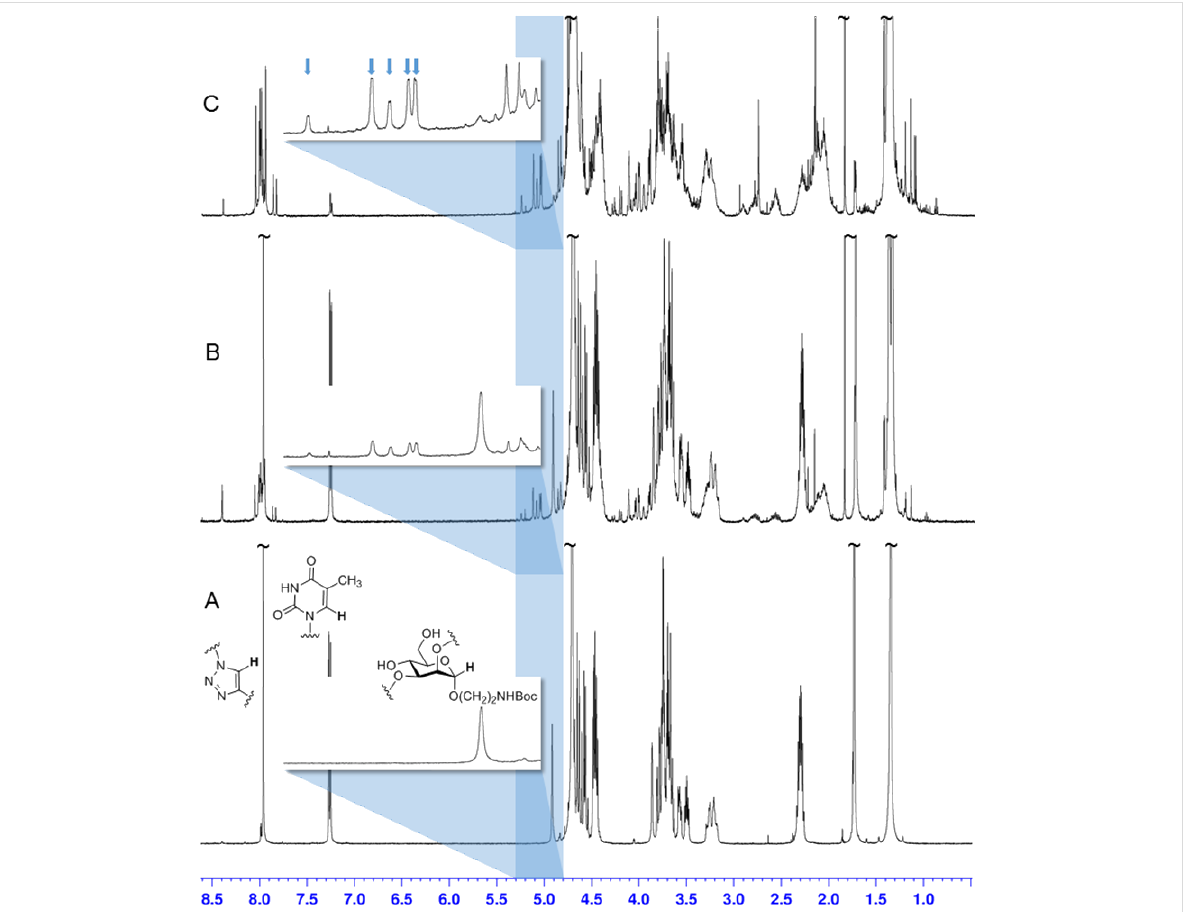
Figure 2: 1 H NMR spectra (all in D 2 O, 500 MHz) of mannoside 7 (A) and of the irradiation product ( 8 ) after 3 hours irradiation time (B) and 6 hours irradiation time (C). Progress of photocycloaddition is seen in the changes of the signals for the triazole H-11 and the thymine H-6 protons (left at low field) and the anomeric H-1 of the carbohydrate scaffold ( ≈ 4.9 ppm). The anomeric H-1 region is detailed in each case: after 6 hours of irradiation (C) five new signals are seen (blue arrows) corresponding to five different isomers of the photocycloaddition product 8